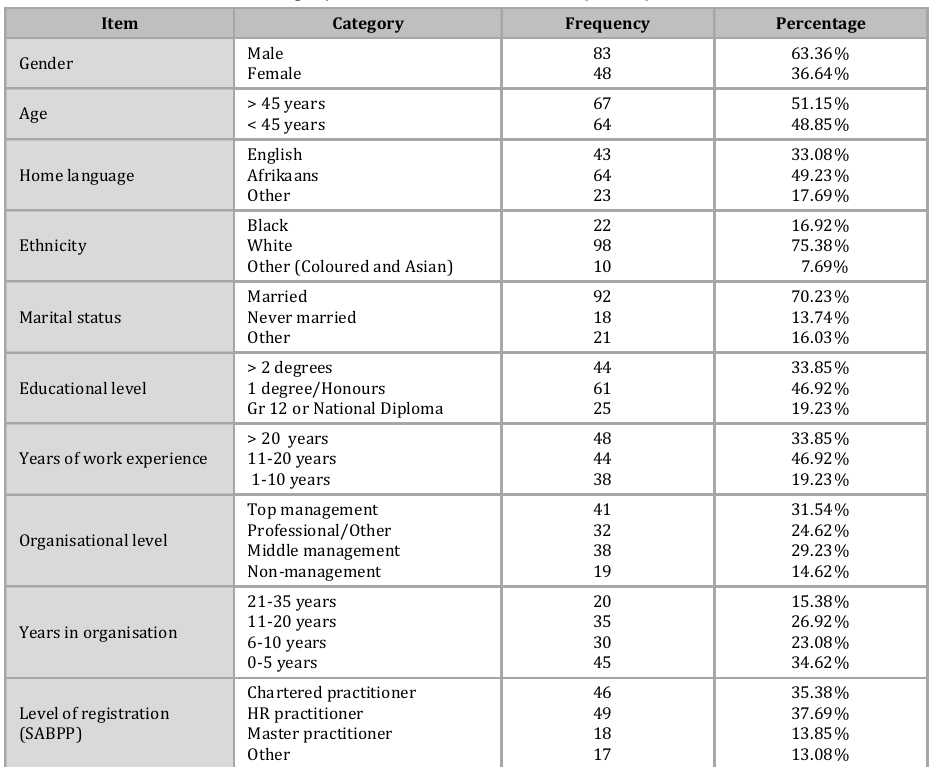
Demographic characteristics of the